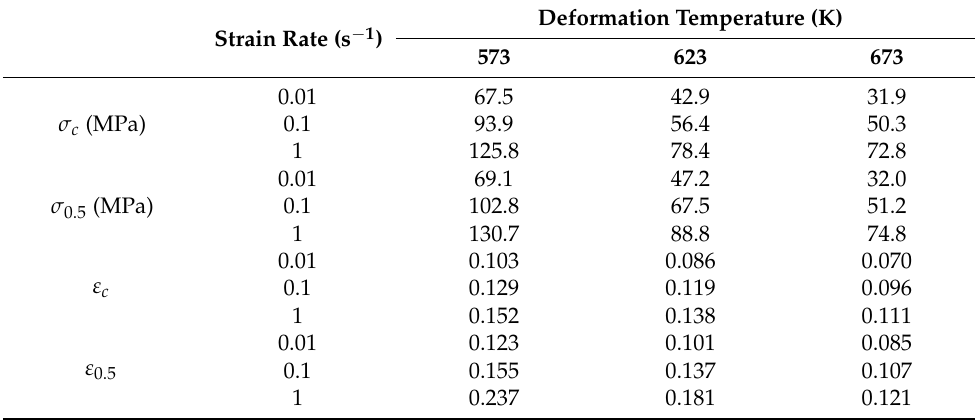
Table 2. σ c , σ 0.5 , ε c and ε 0.5 values at different deformation conditions.